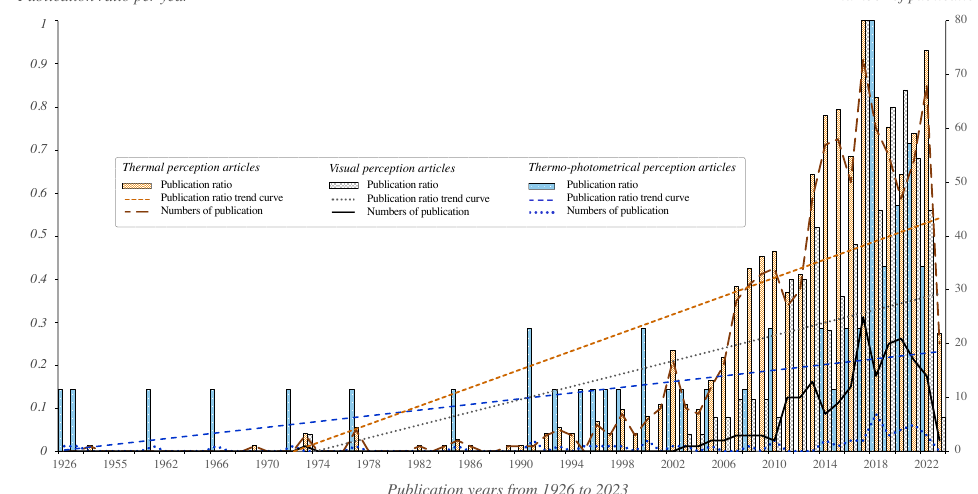
Figure 3. Temporal evolution of the publications number from 1926 to